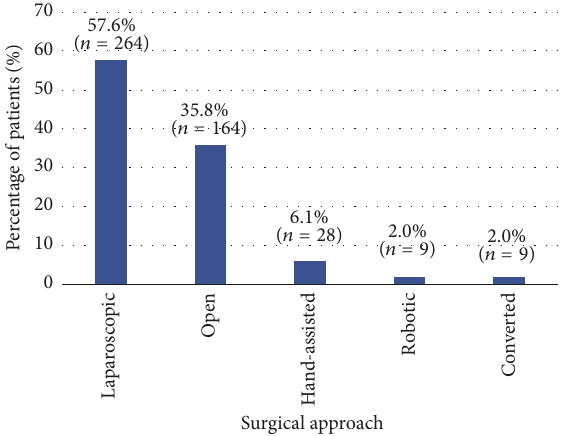
Figure 1: Surgical approach to colorectal resection procedure (overall, 𝑁 = 458 ) . Percentages and absolute numbers of patients with respective approach. Multiple responses were possible ( > 1 approach documented for 16 patients). Specification of converted approach: 7 patients converted from laparoscopic to open, 1 from hand-assisted to open, 1 from robotic to open. Further details and by-country data provided in Supplemental Table 3 . 𝑁 : total number of patients; 𝑛 : number of patients observed per category.